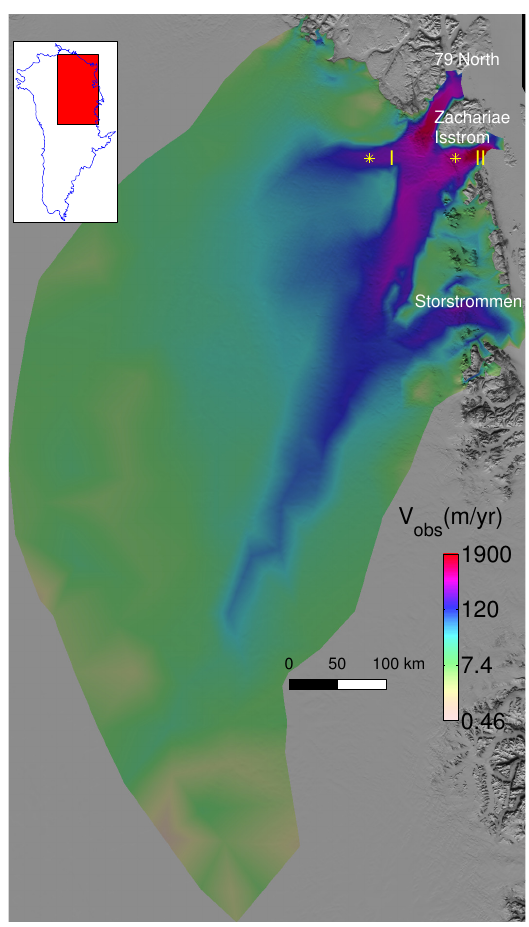
Figure 1. Map of the study area, the Northeast Greenland Ice Stream. InSAR surface velocities from Rignot and Mouginot (2012) are displayed overlayed over the MODIS Mosaic of Greenland (MOG) image map (Haran et al., 2013). The data are projected using the National Snow and Ice Data Center (NSIDC) Sea Ice Polar Stereographic North projection (EPSG:3411) with central meridian at − 45 ◦ and standard parallel at + 70 ◦ . Locations marked in yellow, I and II are used in Fig. (7).